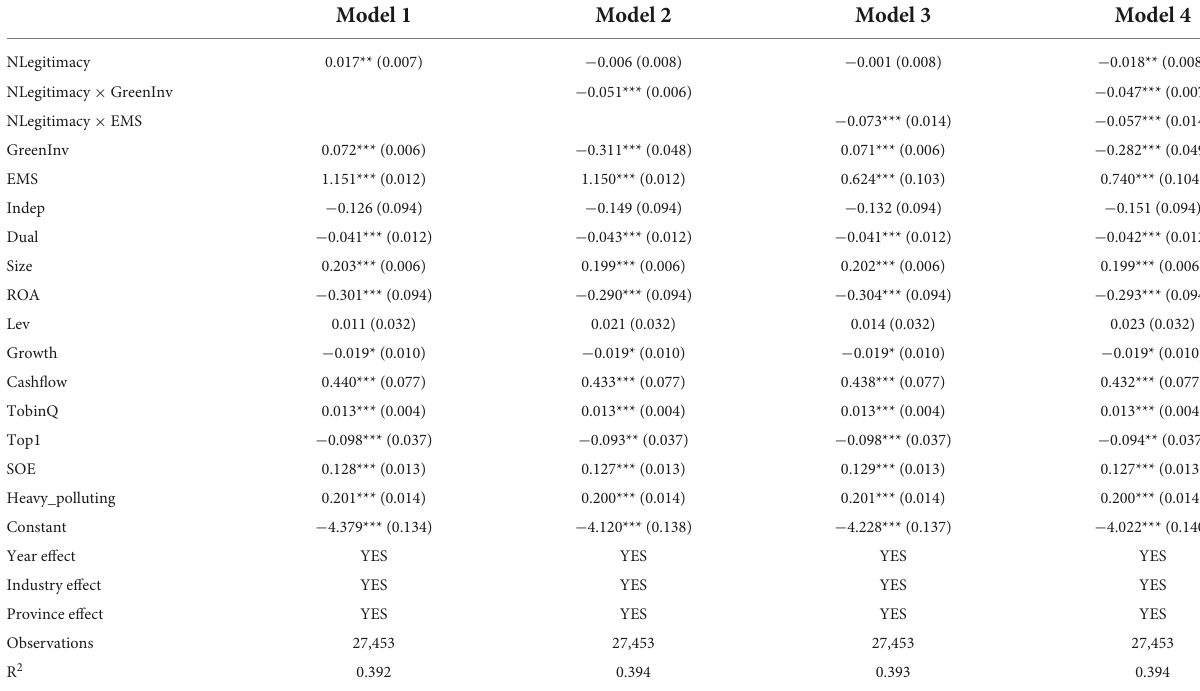
TABLE 7 Robustness check using alternative independent